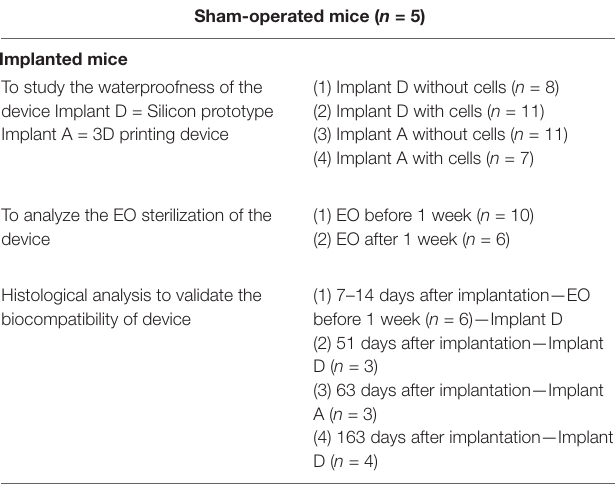
TABLE 1 | Different groups of